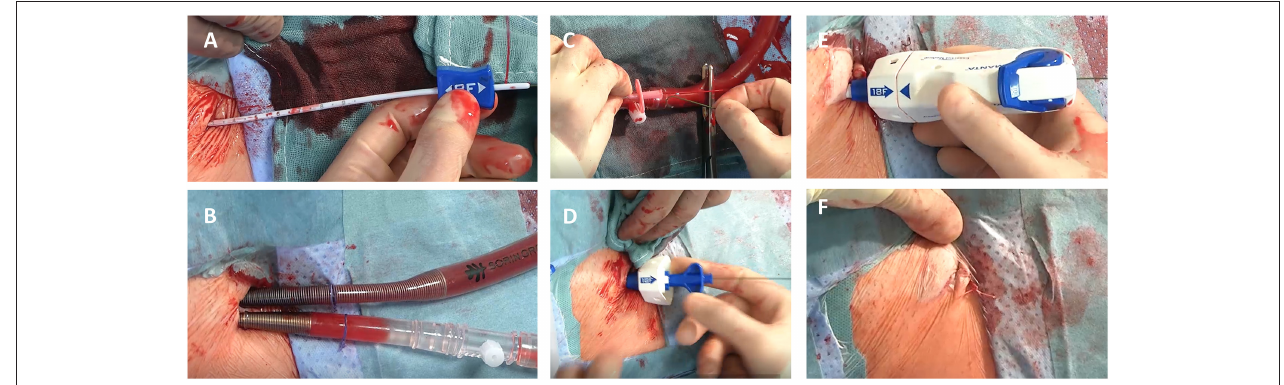
FIGURE 1 | MANTA TM (Teleflex Medical Inc., Wayne, PA, US) vascular closure device for minimally-invasive valve surgery. (A–F) demonstrates percutaneous cannulation/decannulation of femoral artery and vein for cardiopulmonary bypass using a fully percutaneous plug-based vascular closure device: In contrast to surgical exposure of groin vessels a depth locator is inserted over the guidewire to determine the distance from skin level to the endoluminal space of the vessel for later device positioning (A) . Following this, cardiopulmonary bypass is established for minimally- invasive valve surgery (B) . Before final decannulation the arterial cannula is punctured to reinsert the guidewire for percutaneous plug-based vascular closure device (C) . Afterwards the MANTA TM sheath (D) and the closure unit (E) are placed to the predetermined deployment level. After successful hemostasis the MANTA TM device is removed and the suture is cut at the skin level (F) .